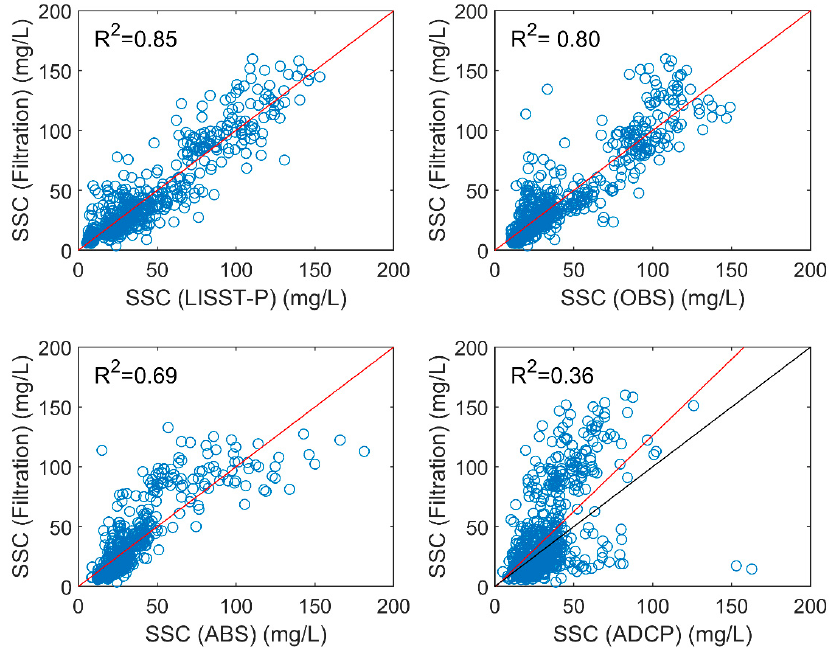
Figure 3. Comparison of predicted and observed values of suspended sediment concentration (SSC) .